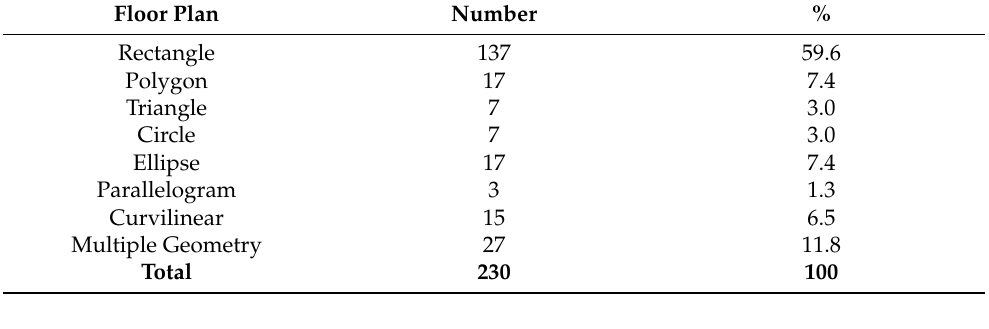
Table 4. Classification of selected tall buildings by floor plan.